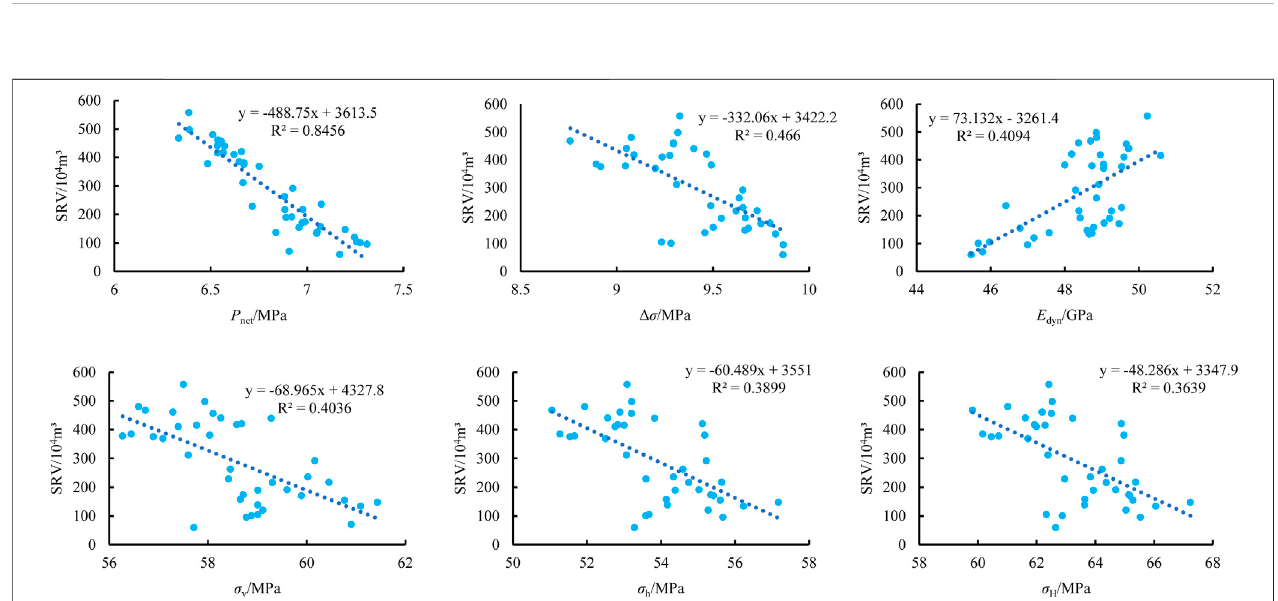
FIGURE 2 | The relationship between single-stage SRV of H6 platform and strong correlation factors.